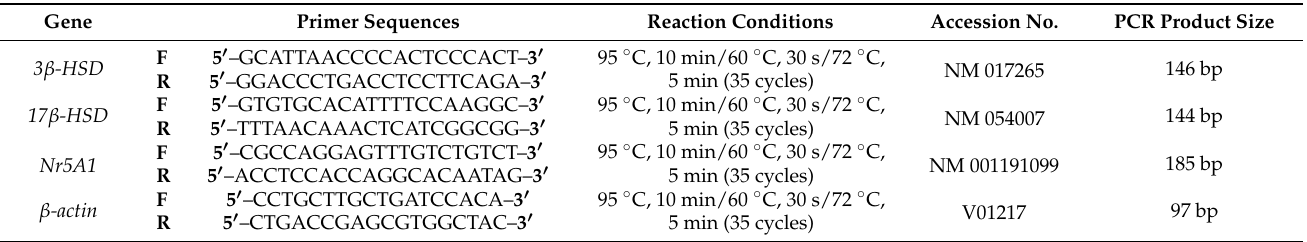
Table 1. Primer sequences, accession number, and product size for the quantitative RT-PCR for the analyzed genes in the testicular tissue.